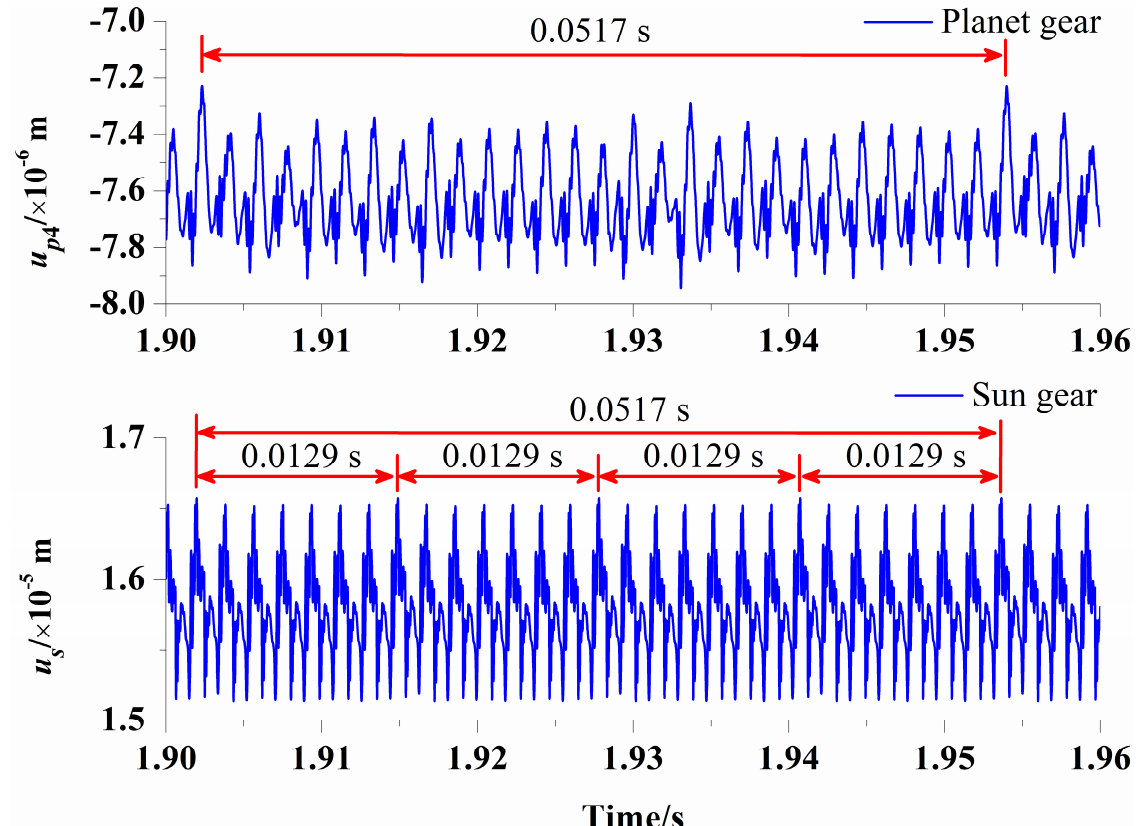
Figure 19. Enlarged view of time histories on sun gear and planet gear. The frequency spectrums of vibration responses on the sun gear and the fourth planet gear are depicted in Figures 20 and 21, respectively. The spectrum of the healthy case consists of mesh frequency f m and its harmonics. The tooth crack is supposed to induce sidebands in the frequency spectrums. However, it is hard to observe sidebands for case 1, as the tooth crack is in the early stage. When the tooth crack propagates to case 3 and case 5, the sideband becomes obvious, and its amplitude increases correspondingly. This means that the sideband of frequency spectrum could reflect the tooth crack except for in the early stage. For the frequency spectrum of the sun gear, the frequency interval of the sideband is exactly the faulty frequency f fs , while that of the planet gear is the relative rotational frequency f rs . The reason is the same as that explained